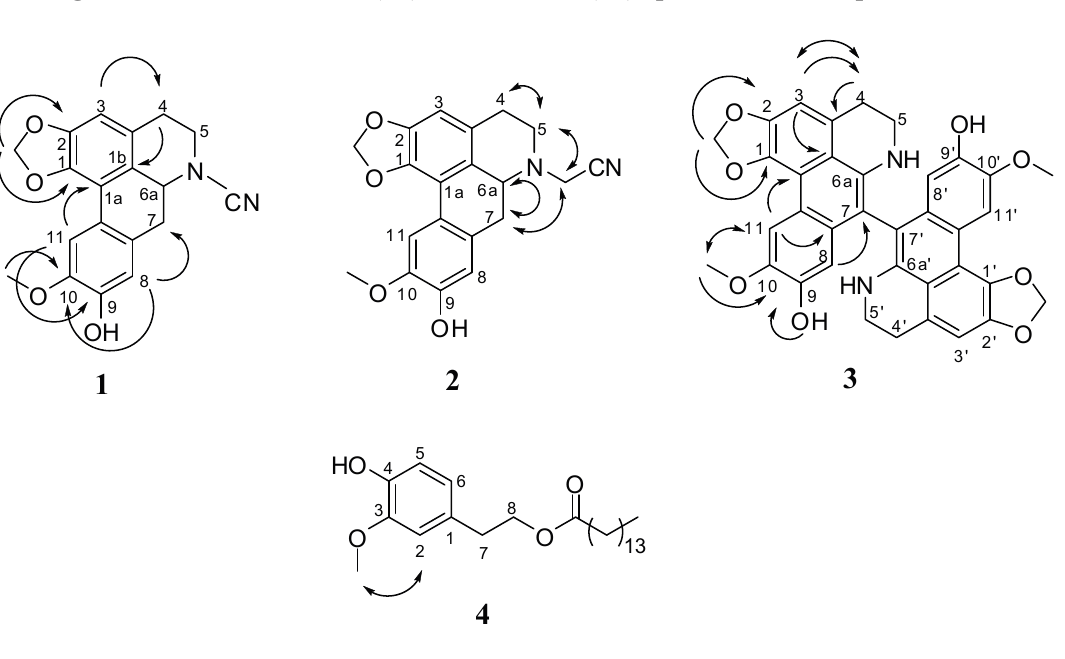
Figure 1. Selected HMBC ( → ) and NOESY ( ↔ ) spectrum for compounds 1 – 4